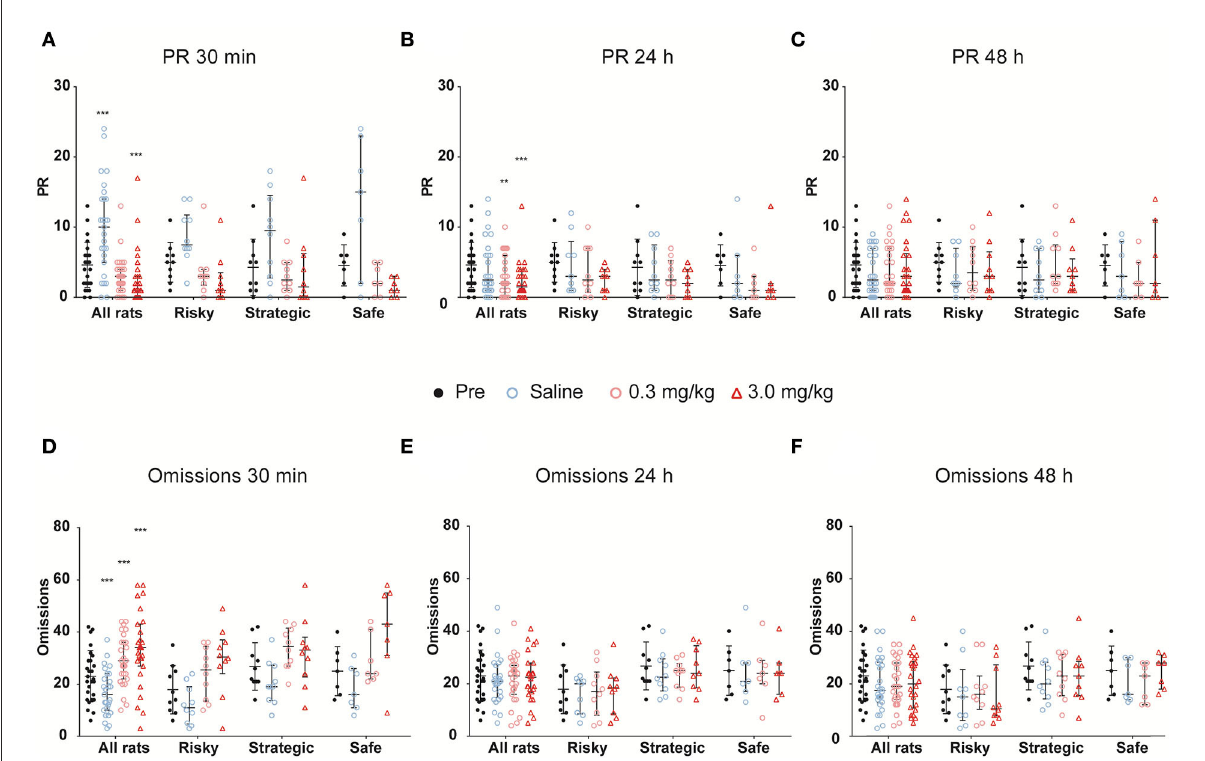
FIGURE7 The effects of naltrexone on (A–C) premature responses (PRs) and (D–F) omissions when assessed (A,D) 30min, (B,E) 24h, and (C,F) 48h after treatment with naltrexone (0.0, 0.3, and 3.0 mg/kg) in all rats irrespectively of rGT strategy as well as in rats with risky ( n = 7), strategic ( n = 10), and safe ( n = 10) rGT strategies. Each figure contains the data prior to treatment (pre, mean of 3 days prior) as a baseline comparison. Data are presented as individual rats with group median and quartile range marked. ** < 0.01, *** < 0.001 compared to pre-treatment in all rats ( post hoc Wilcoxon matched-pairs